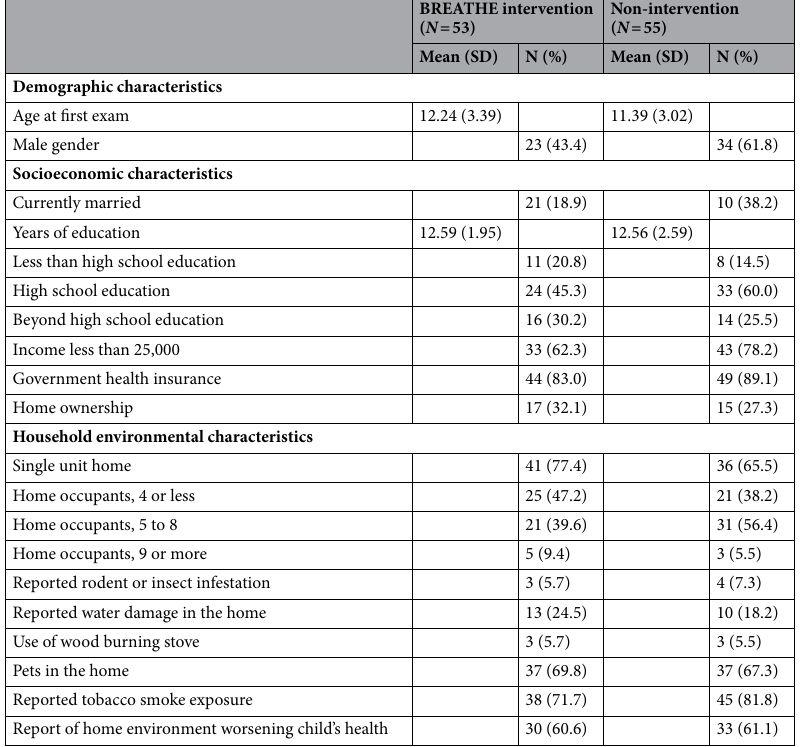
BREATHE intervention ( N =